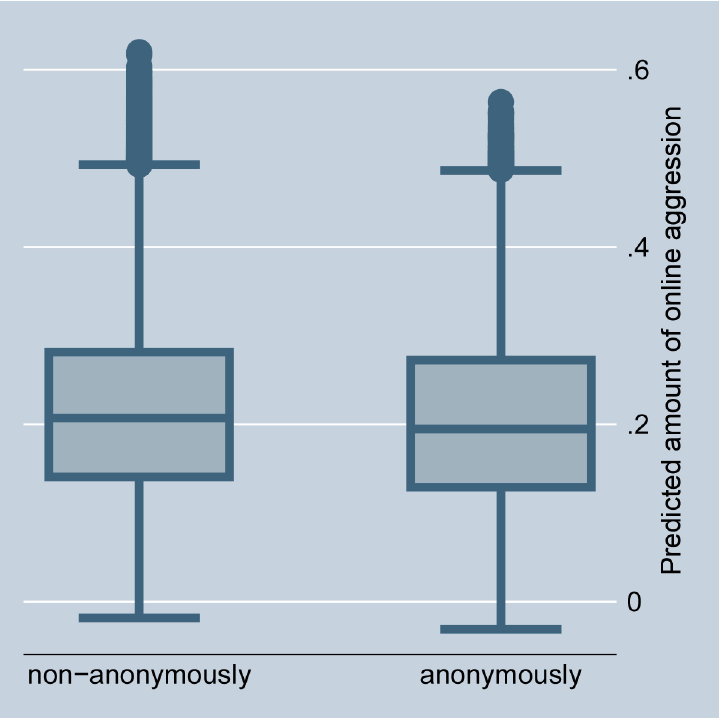
Fig 6. Online aggression dependent on anonymity of commenters (random-effects). Predictions of Table 1, Model 1.